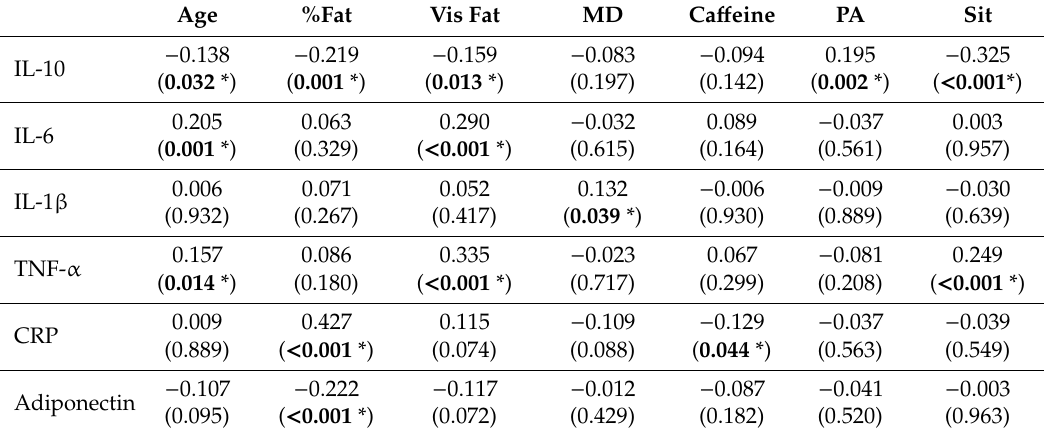
Table 4. Bivariate correlations between dependent and independent variables (all